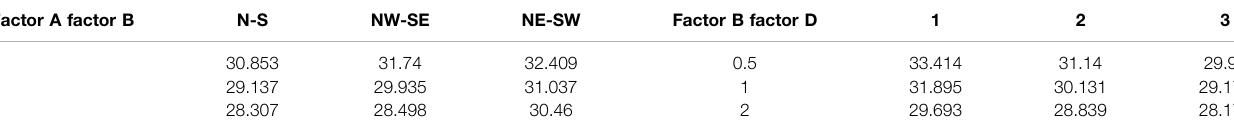
TABLE 7 | Calculation of interaction between factors A and B, and factors B and D in the street canyon model. Factor A factor B